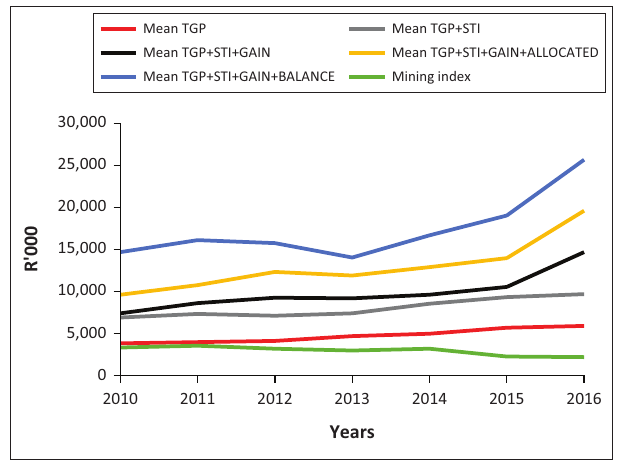
FIGURE 1: Chief executive officer’s remuneration: Mean (R’000).